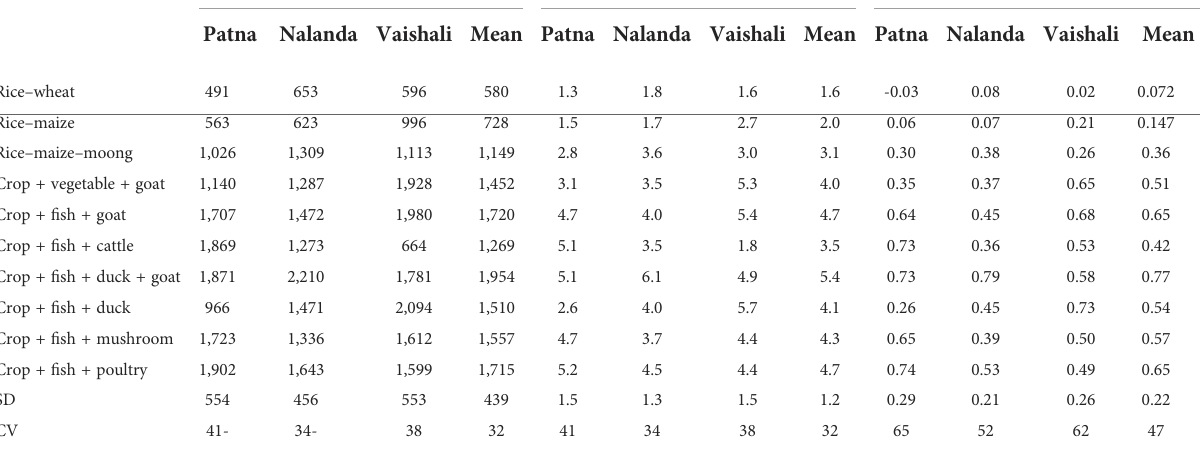
TABLE 7 Net returns and sustainability index of different integrations (mean value of 6 years, 2016 – 2021).